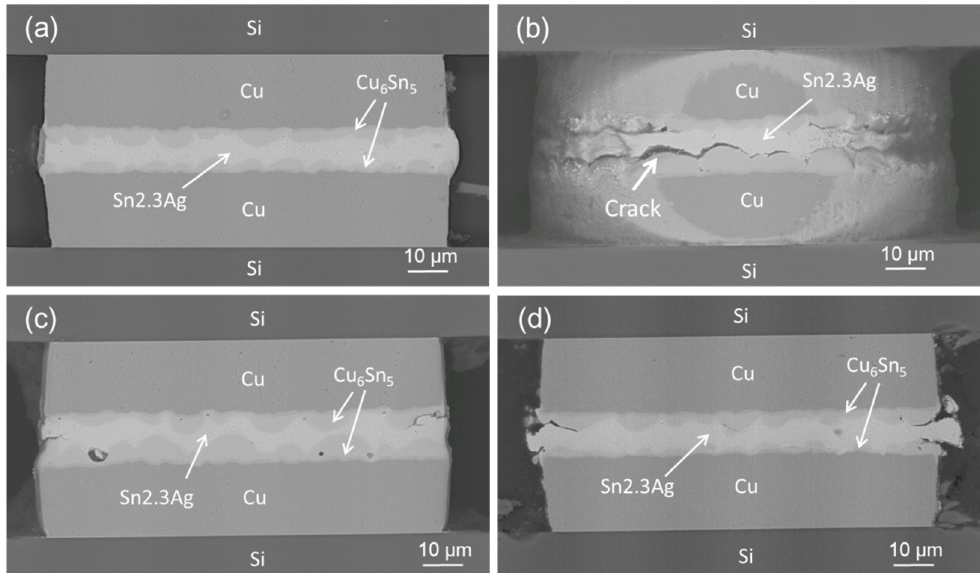
Figure 1. Cross-sectional SEM BEIs of the non-IMC-bridging Cu/solder/Cu microbumps ( a ) as-fabricated after a TCT for ( b ) 1000 cycles (edge-polished site), ( c ) 1000 cycles, and ( d ) 2000 cycles. Arrows designate the IMCs. SEM: scanning electron microscope. BEI: backscattered electron image. IMC: intermetallic compound. TCT: thermal cycling test.